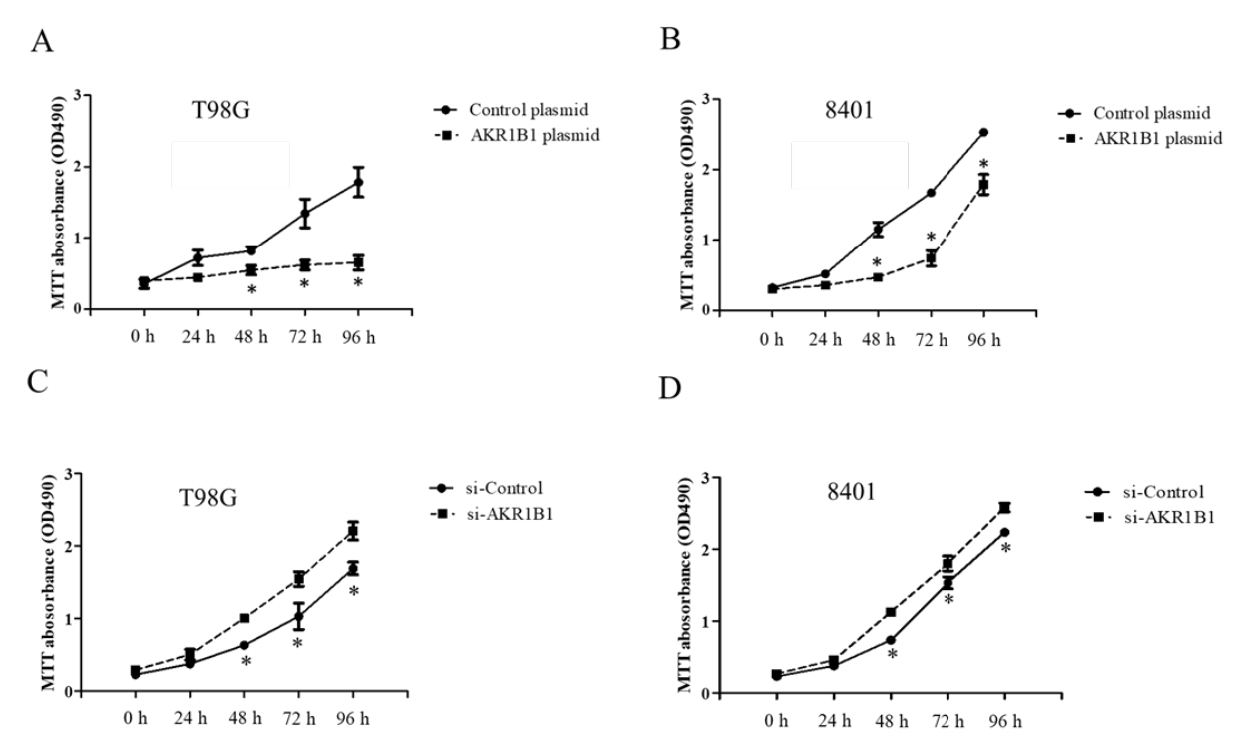
(right panel) analysis results show increased AKR1B1 protein and mRNA levels at 24 h after trans- fection with the AKR1B1 plasmid in T98G cells, respectively, ( n = 3). ( B ) Western blot (left panel) and q-RT-PCR (right panel) analysis results reveal that AKR1B1 protein and mRNA levels signifi- cantly declined at 72 h after siRNA transfection in 8401 cells ( n = 3). Data are presented as mean ± SEM comparing 8401 glioma cells treated with the control plasmid (CN plasmid) or the control si- RNA (si-CN); * p < 0.05 and ** p < 0.01.